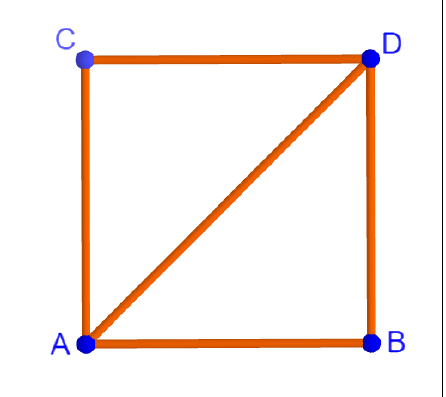
Figure 7. A finitely rigid plane